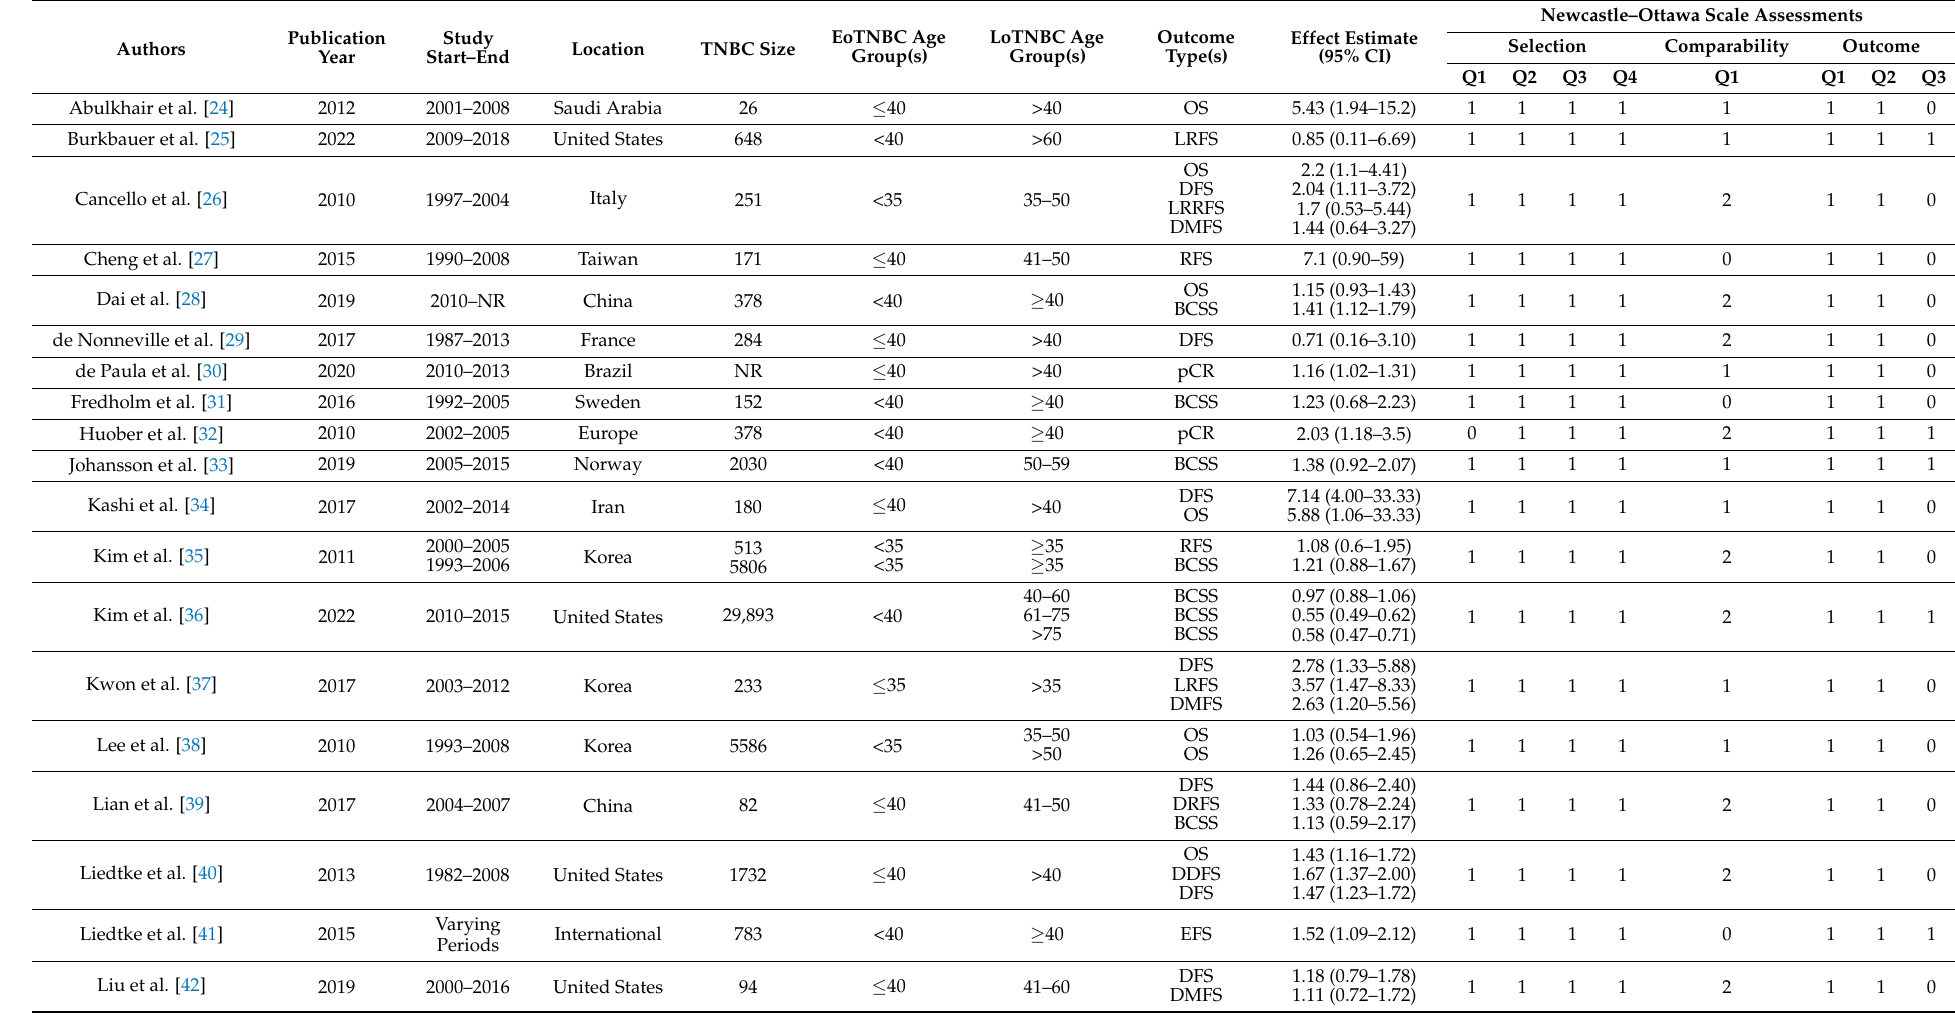
Table 1. Characteristics and quality assessment of included